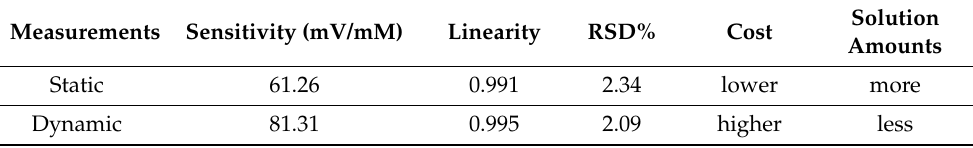
Table 2. Comparisons of static and dynamic